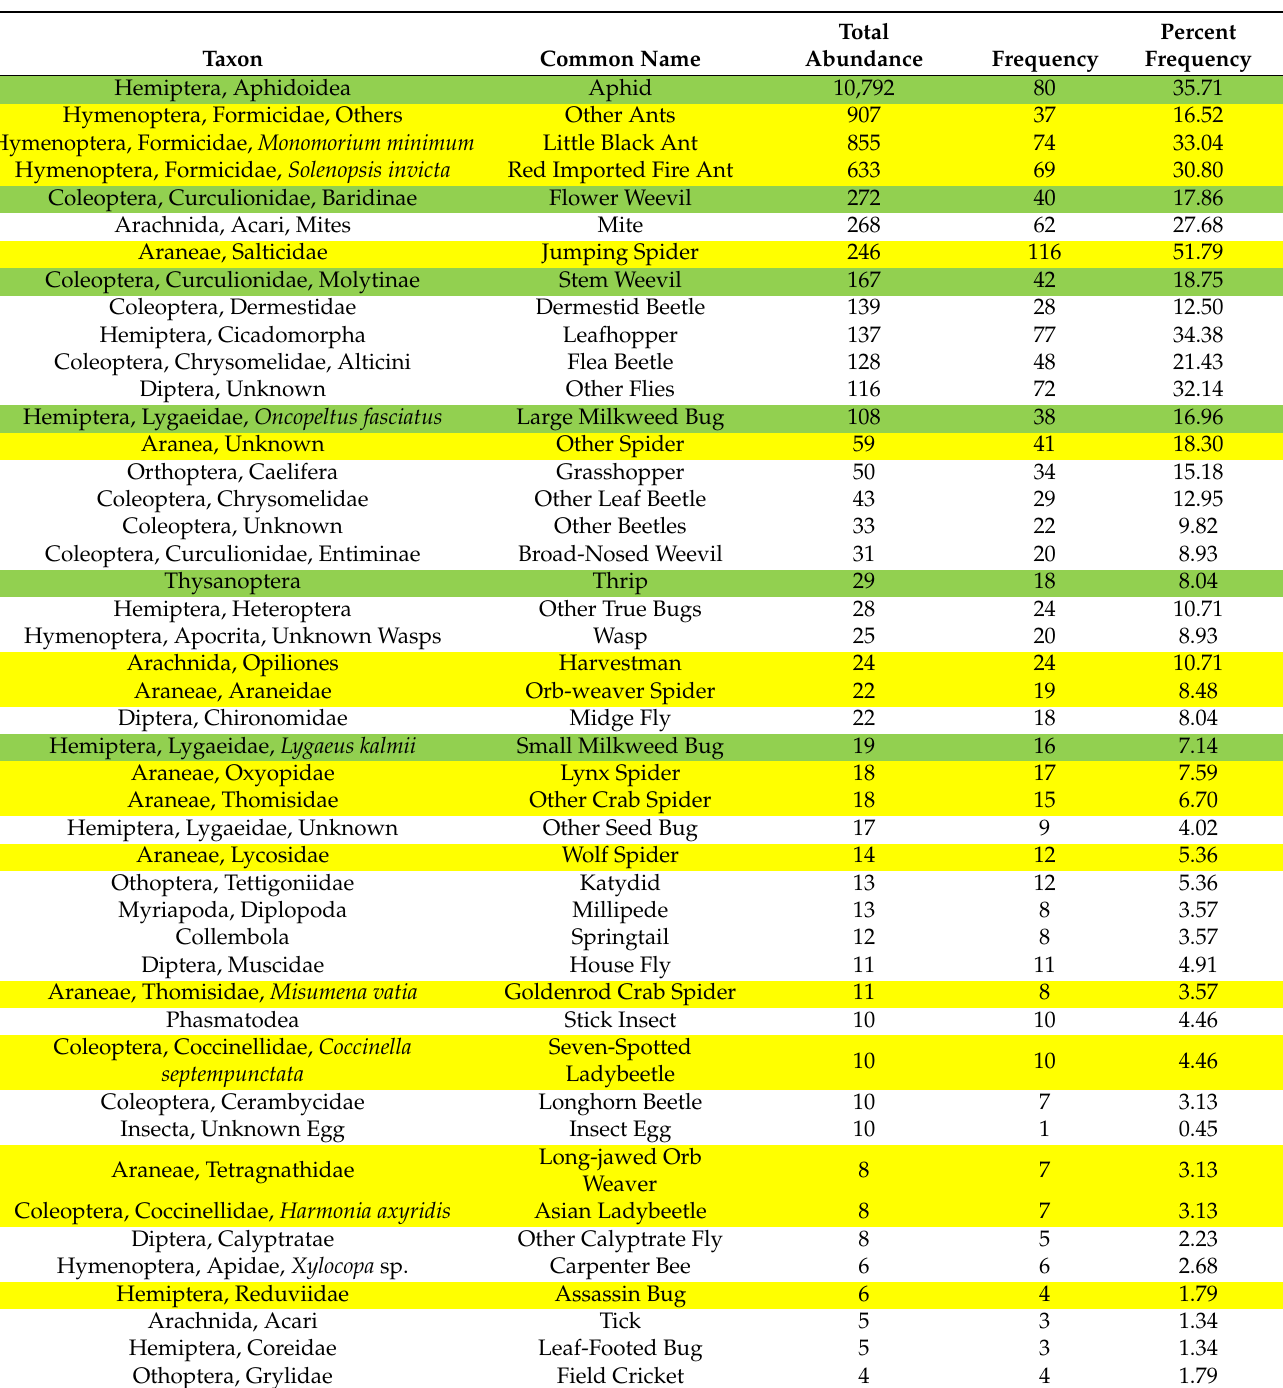
Table A1. Arthropod taxa associated with 224 monarch egg and larva host plants. Rows highlighted in yellow represent predatory taxa. Rows highlighted in green represent herbivorous taxa known to feed on milkweed or observed to do so in this study. All other taxa were considered to be either nectaring: harboring, or transient. Percent frequency is the percentage of eggs that a taxon was associated